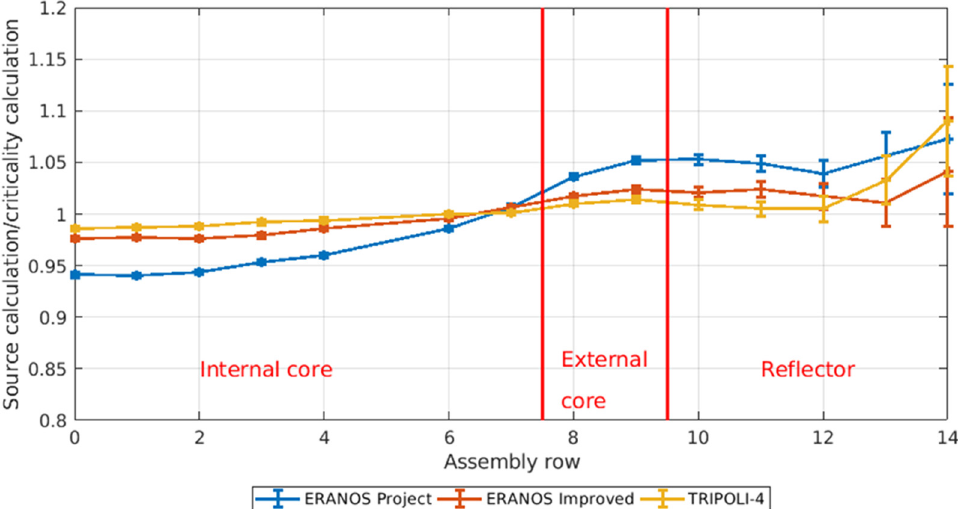
Fig. 8. Radial fl ux traverse comparison between shielding calculations using sources from different origins and the criticality